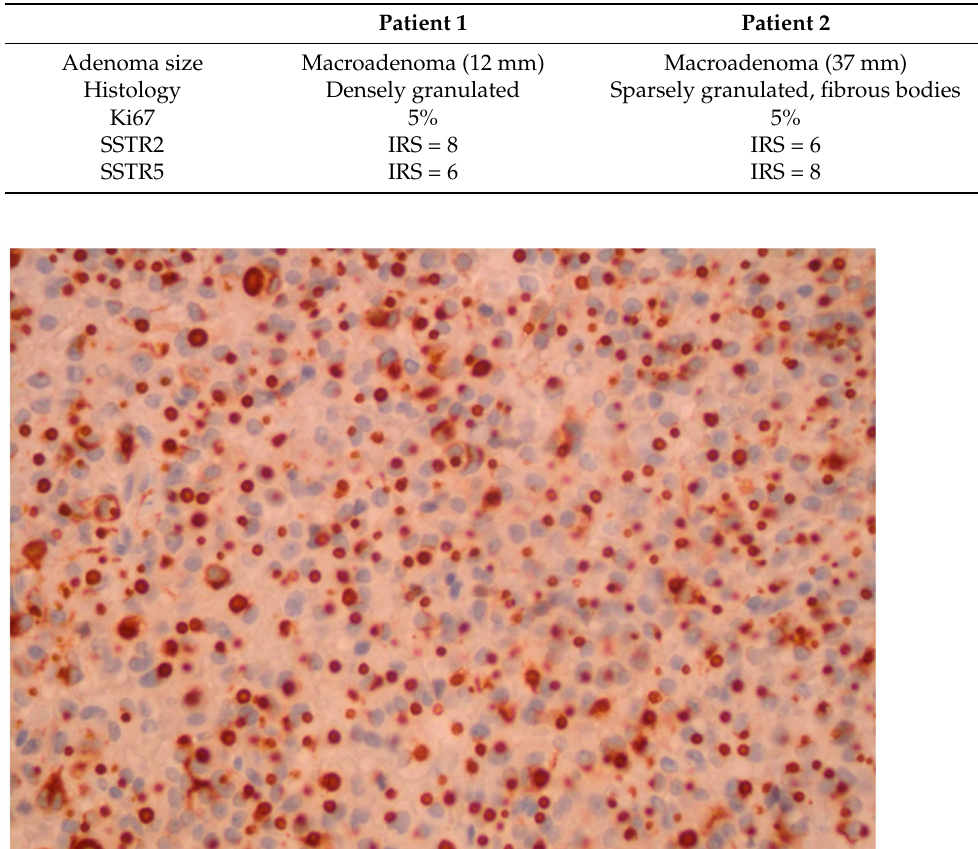
Table 3. Prognostic factors.